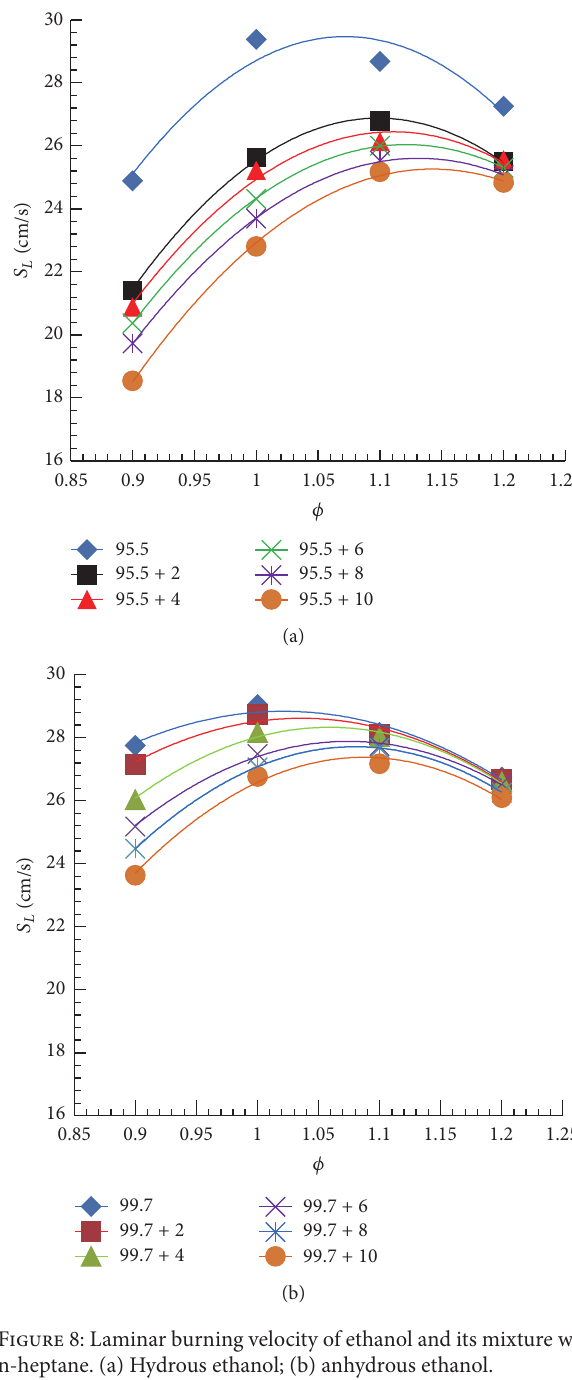
Figure 8: Laminar burning velocity of ethanol and its mixture with n-heptane. (a) Hydrous ethanol; (b) anhydrous